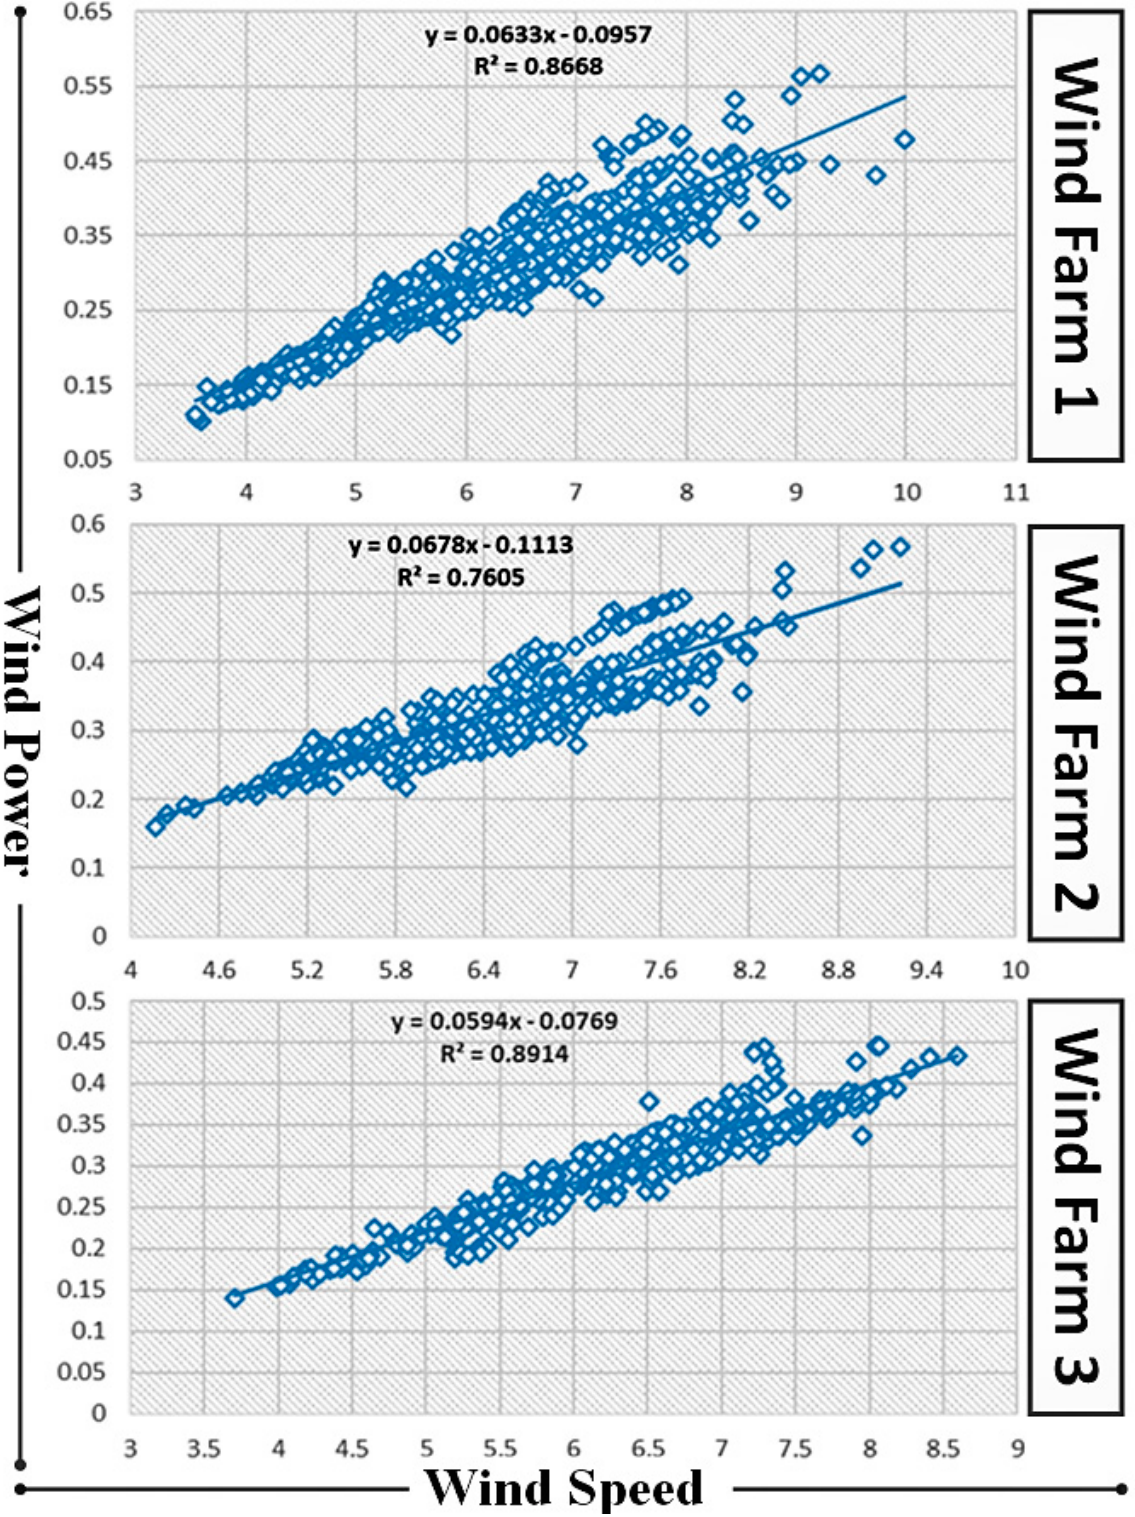
Figure 10. R-squared association between wind power (kW) and wind speed (m/s) variables for Windfarms 1, 2 and 3.